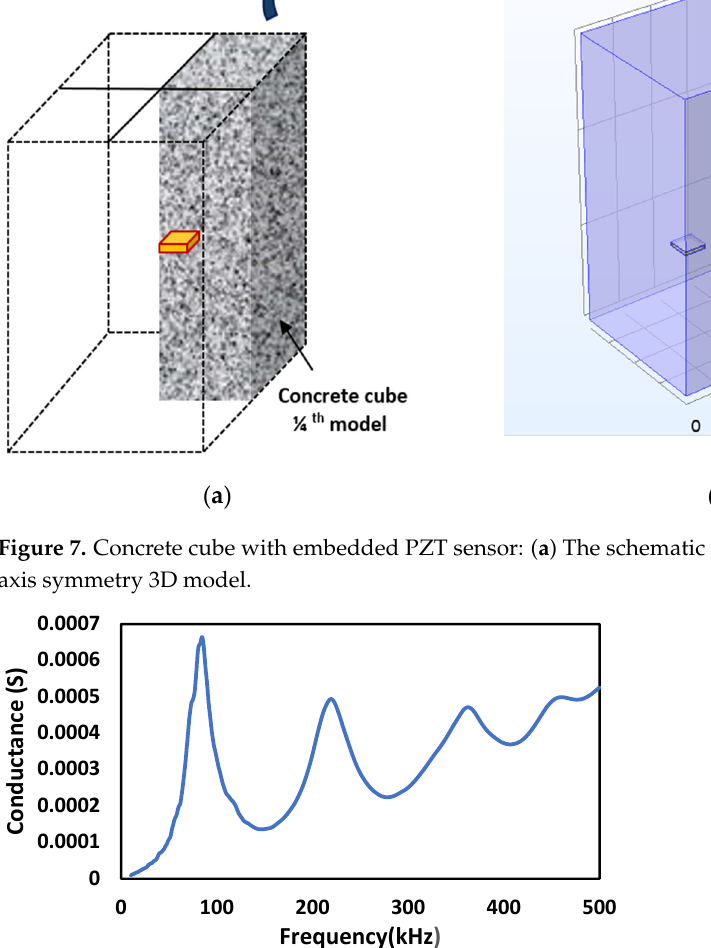
Figure 8. Conductance response obtained for embedded PZT patch in concrete.